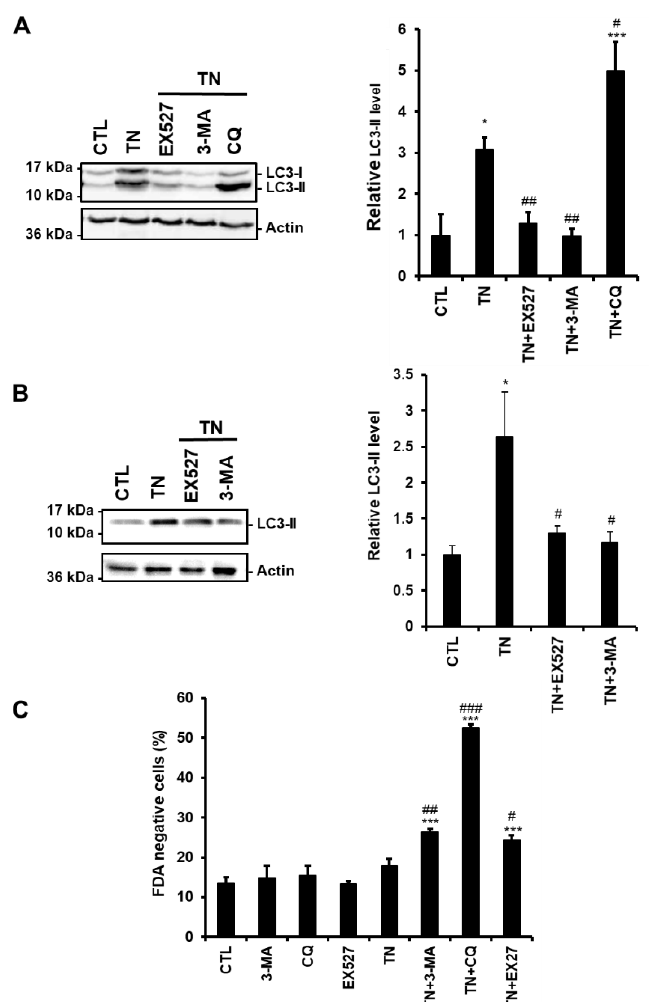
Figure 3. SIRT1 inhibition reduces the amount of LC3-II induced by ER stress. ( A , B ) The levels of the autophagic marker LC3-II were analyzed by Western blot in H9c2 cells (24 h) ( A ) or ARVM (4 h) ( B ) untreated or treated with tunicamycin (TN) (10 µ g / mL) ± 50 µ M EX527 (SIRT1 inhibitor), 5 mM 3-Methyladenine (3-MA) or 50 µ M chloroquine (CQ) pretreatment. Actin was used as a loading control. Relative expression of proteins is presented in the bar graphs as mean ± S.E.M. (n = 4). ( C ) ARVM were left untreated or treated with 10 µ g / mL tunicamycin (TN) for 24 h ± 50 µ M EX527, 5 mM 3-Methyladenine (3-MA) or 50 µ M chloroquine (CQ) pretreatment and cell viability was determined by Fluorescein Diacetate (FDA) assay. Results presented in the bar graph are expressed as mean ± S.E.M. of percentages of dead cells (FDA negative cells, n = 3). * P < 0.05, ** P < 0.01, *** P < 0.005 versus control. # P < 0.05, ## P < 0.01, ### P < 0.005 versus TN.